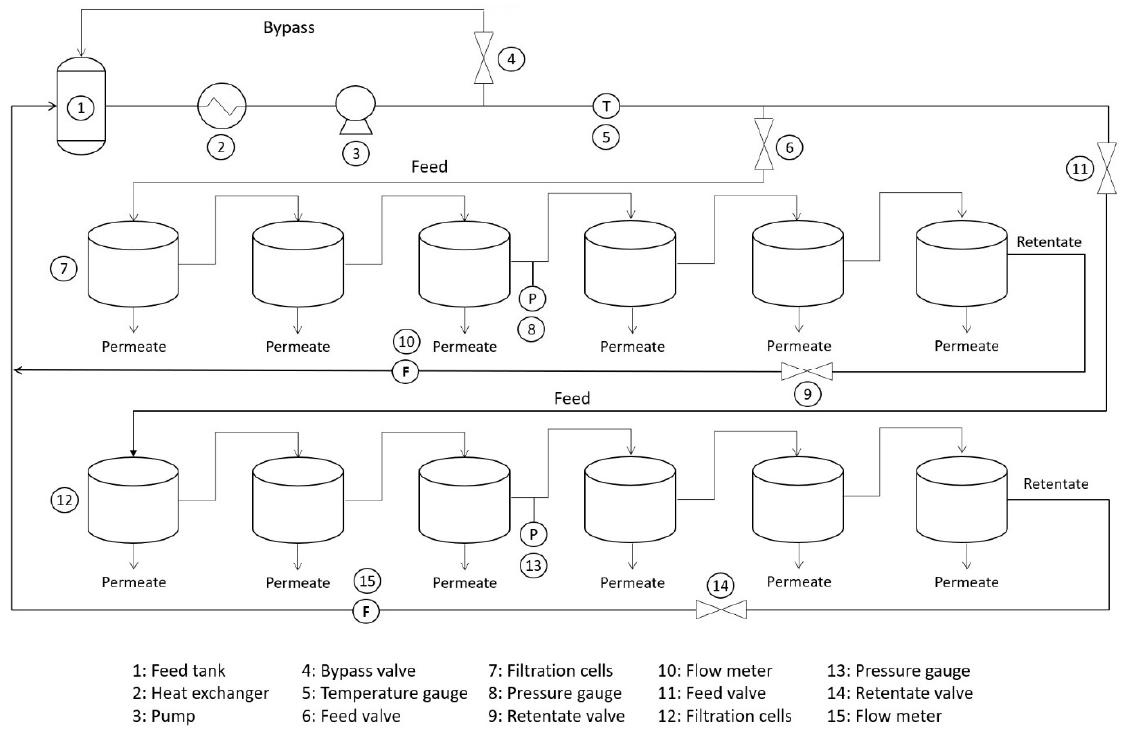
Figure 4. NF membrane coupons tester set-up.